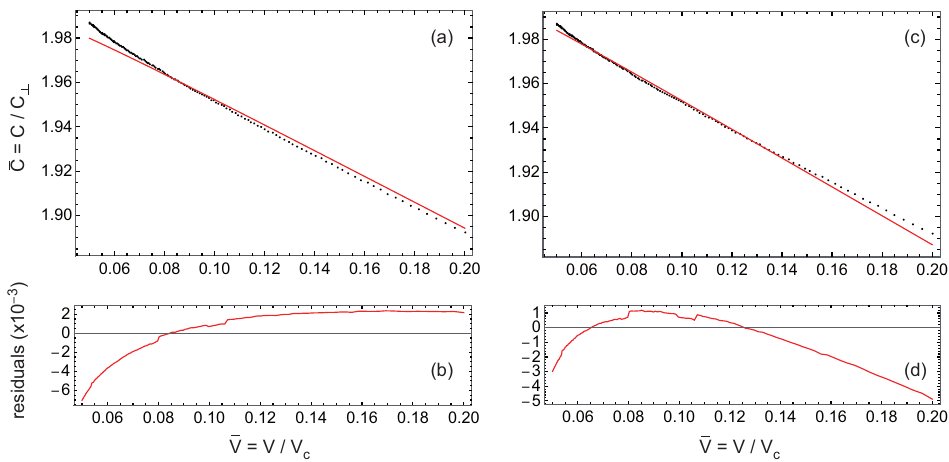
Figure 8. Capacitance curve measured at T = 40 ◦ C (the dots are the experimental points) and its fits to Equations (4) and (5) (solid lines) calculated by taking κ = − 0.08 and L = 0.045 µ m ( a , b ) or κ = 0.72 and L = 0.05 µ m ( c , d ). Here ε (cid:107) is assumed to be constant and equal to ε (cid:107) ( 0 )